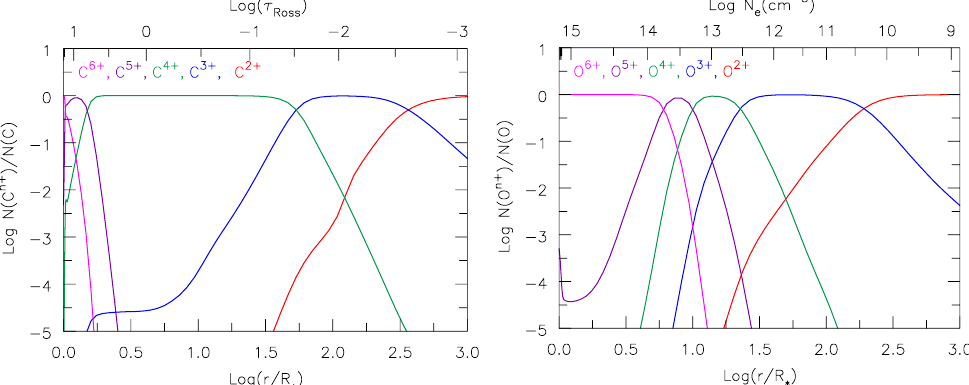
Figure 11. Illustration of the stratified ionization structure in the WC4 star, BAT99-9. On the top axis we show the Rosseland optical depth ( left plot ) and the electron density in units of electrons per cm 3 ( right plot ). The top scales are not linear. As we move out in the wind, the ionization decreases. This variation is verified by the emission profile line widths—O VI lines are narrower than O III